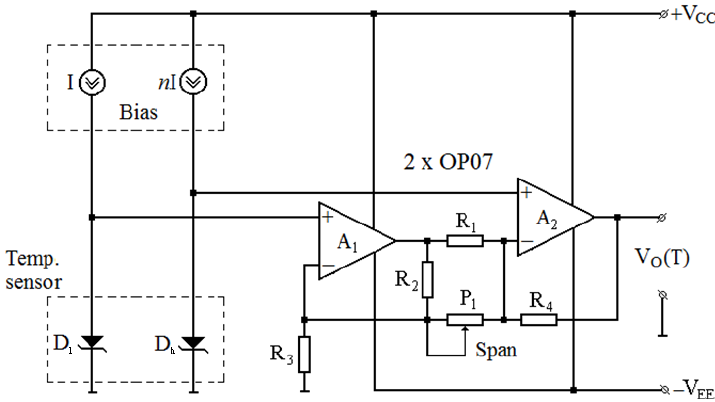
Figure 2. Schematic of the differential temperature measurement circuit.